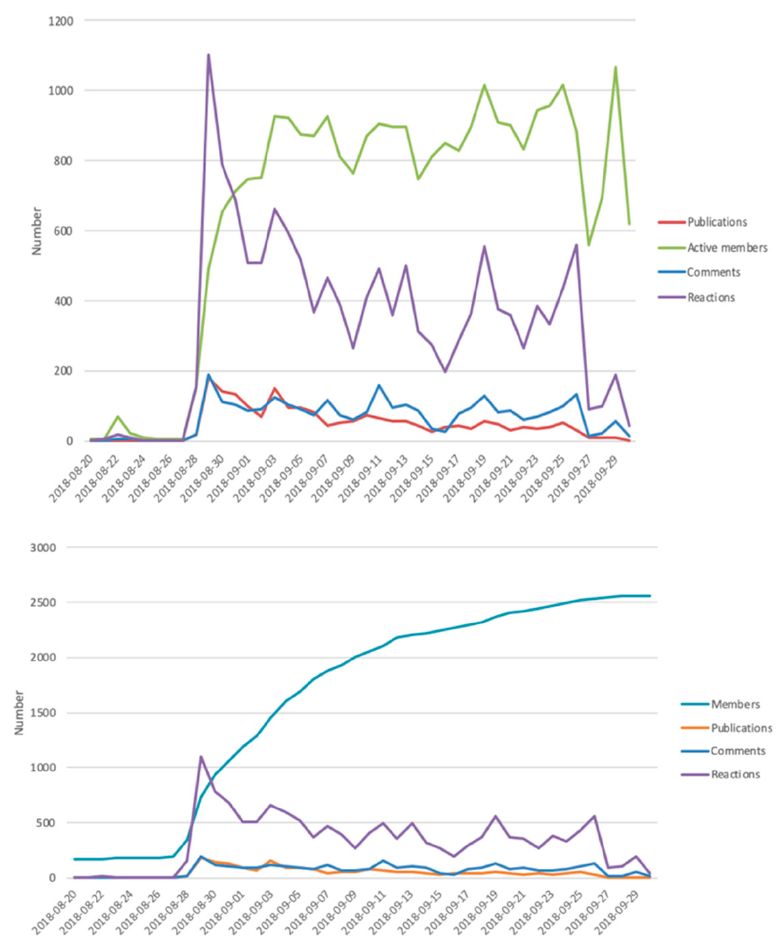
Figure 4. VLC publications ( top ) and members evolution ( bottom ).